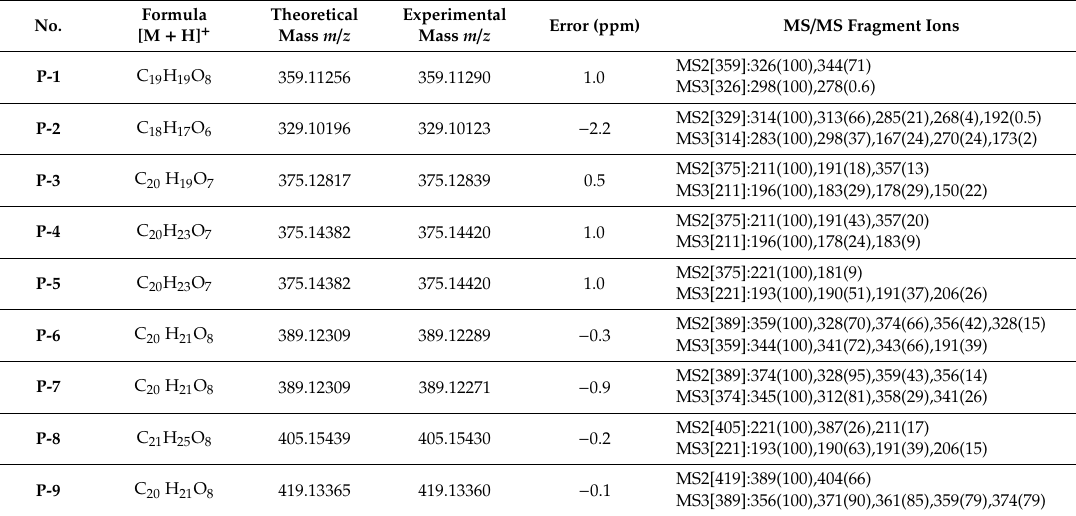
Table 1. Identification of nine PMFs reference standards in positive